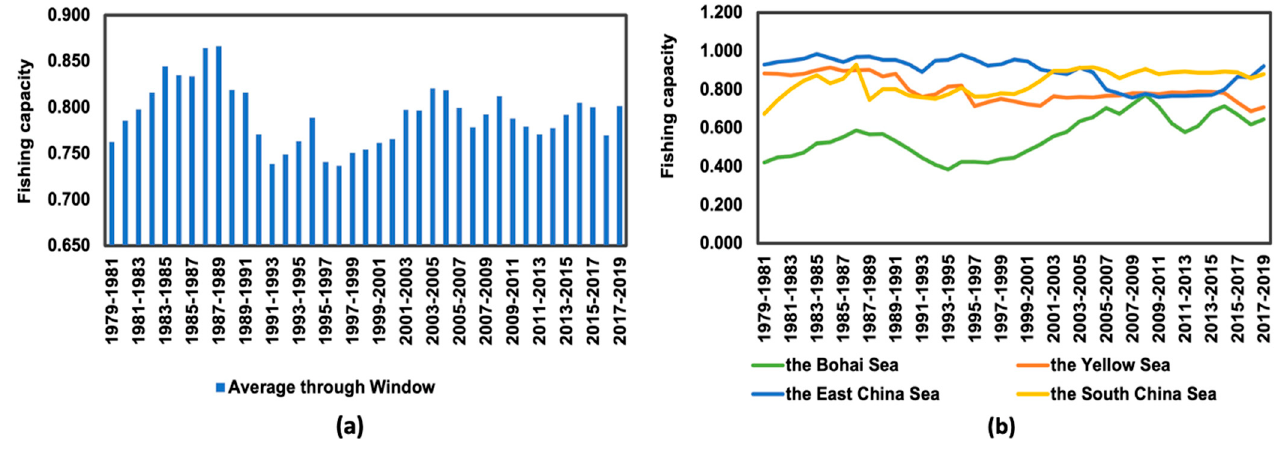
Figure 3. Results of window-DEA. ( a ) Averages for all of China; ( b ) Averages for different seas.